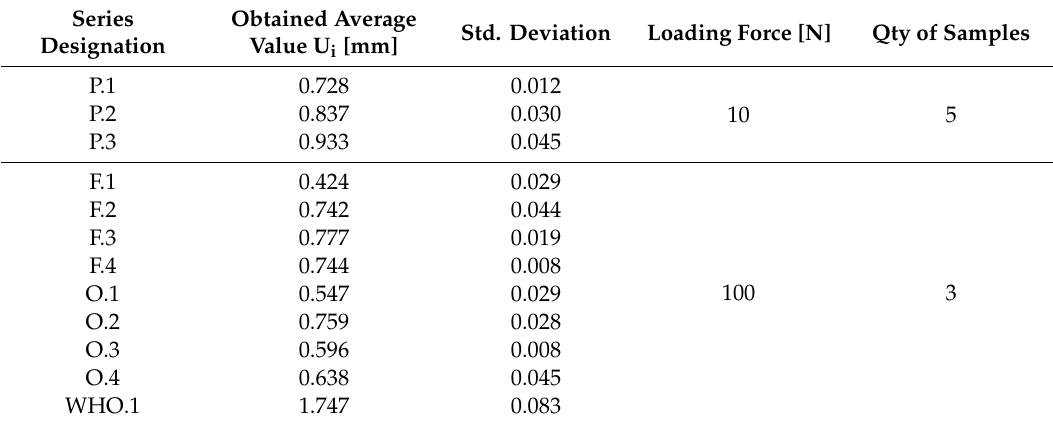
Table 4. The obtained average values of the U i displacement from the P series of samples.